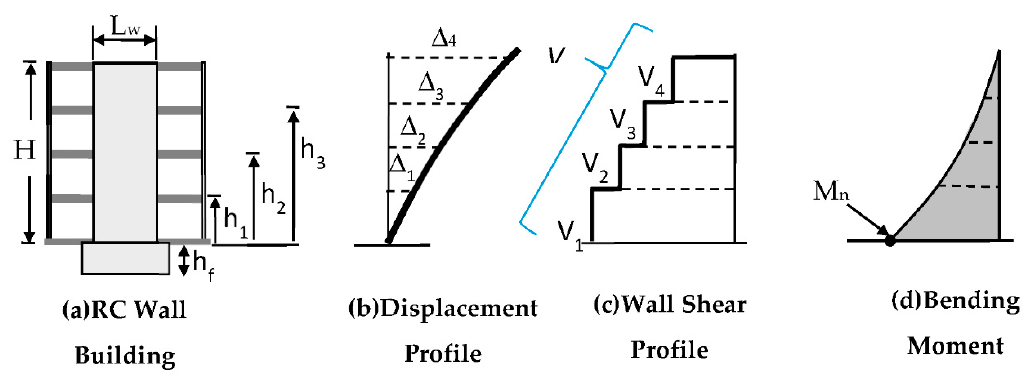
Figure 2. Equivalent first mode lateral displacement, shear, and moment diagrams for a cantilever RC wall building.